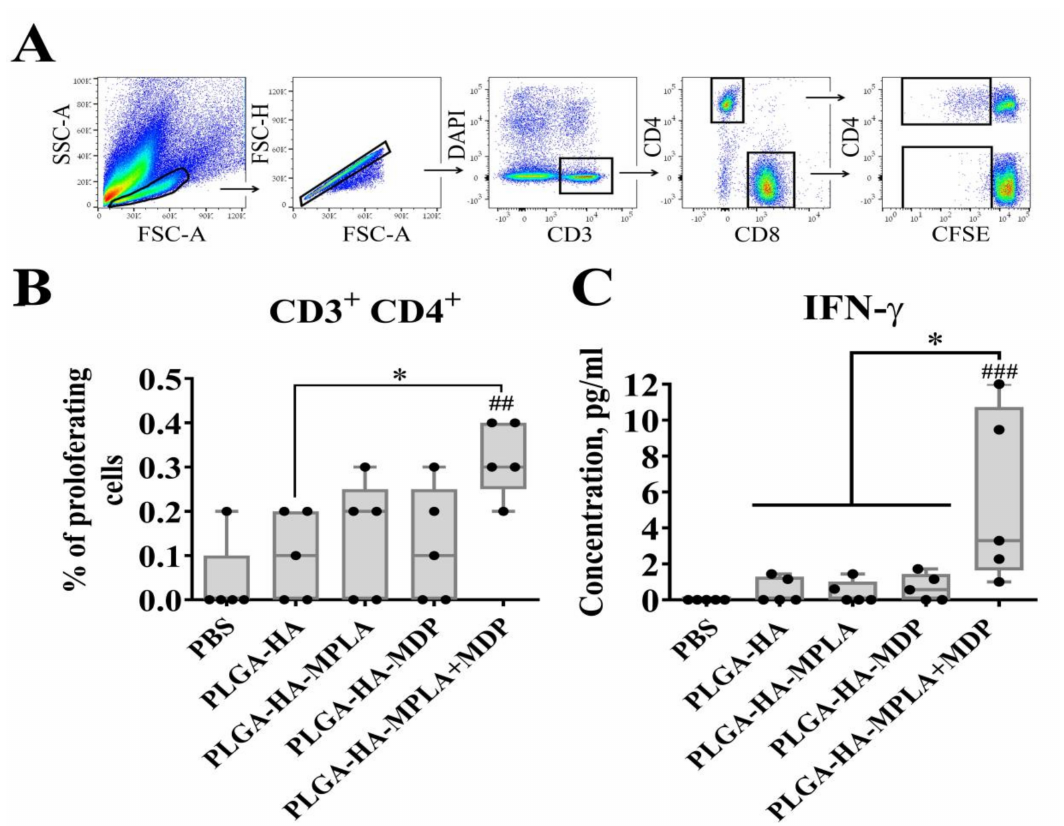
Figure 7. PLGA NPs containing both MPLA and MDP induce stronger antigen-specific CD4 + T-cell response in mice than NPs containing individual PRR agonists. C57BL / 6 mice ( n = 5 / group) were i.m. immunized three times with PLGA NPs: PLGA-HA, PLGA-HA-MPLA, PLGA-HA-MDP, and PLGA-HA-MPLA + MDP with a two-week interval. Non-immunized control mice received PBS. Splenocytes were harvested from mice 14 days after the last immunization. Splenocytes were stained with CFSE, treated with whole hemagglutinin (1 µ g / mL). 72 h after cell were harvested for cellular proliferation analysis, cell culture was collected for IFN- γ detection. ( A ) Gating strategy for assessment of proliferating T cells in culture. Single lymphocytes were gated using the forward and side scatter characteristics. Live (DAPI negative) CD3 + T cells were then obtained from the single cells gate. CFSE dim cells were gated in each CD3 + CD4 + as well as CD3 + CD8 + populations. ( B ) % of proliferating CD4 + T-cells (referred to fraction diluted) in response to hemagglutinin